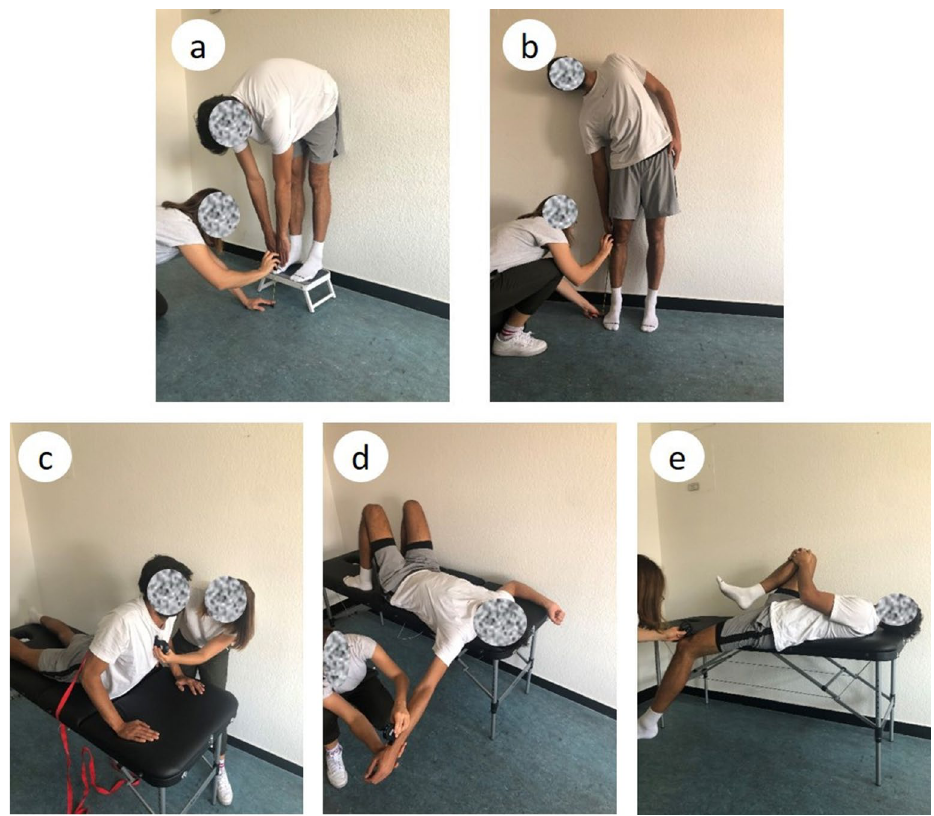
Figure 1. The ROM tests examined in this study. ( a ) Fingertip-to-Floor test; ( b ) Lateral Inclination test; ( c ) Retroflexion of the trunk after Janda in a modified version; ( d ) Shoulder test modified after Janda; ( e ) Modified Thomas